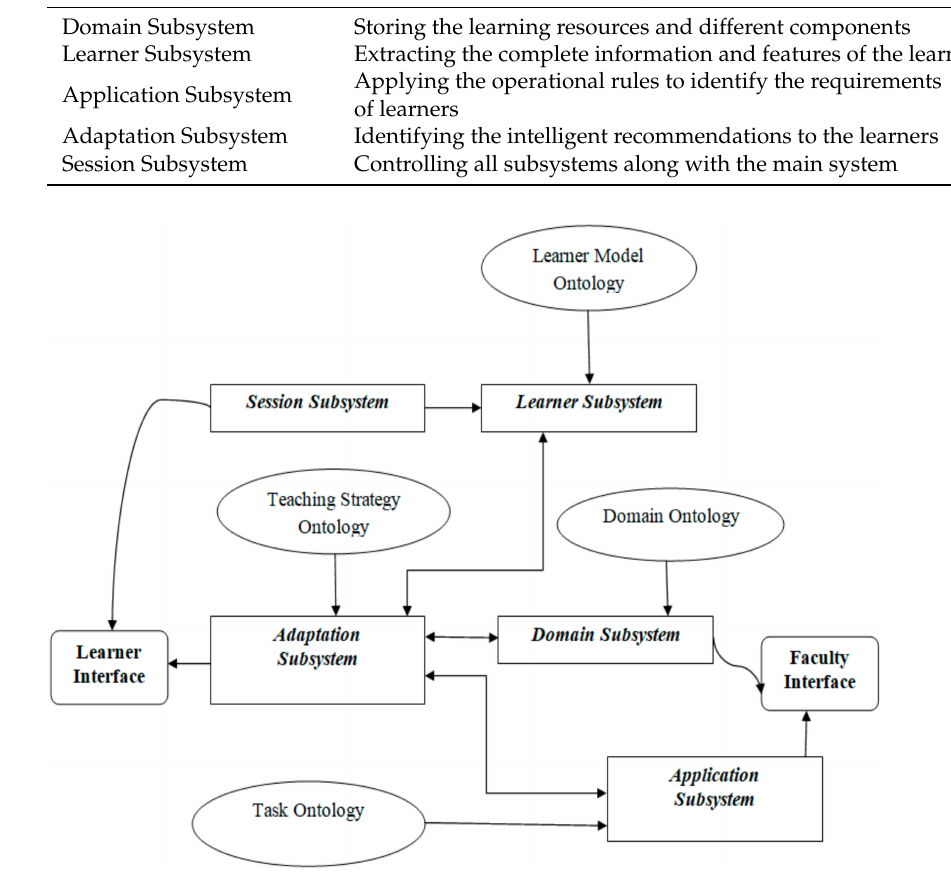
Figure 1. The overall recommendation system